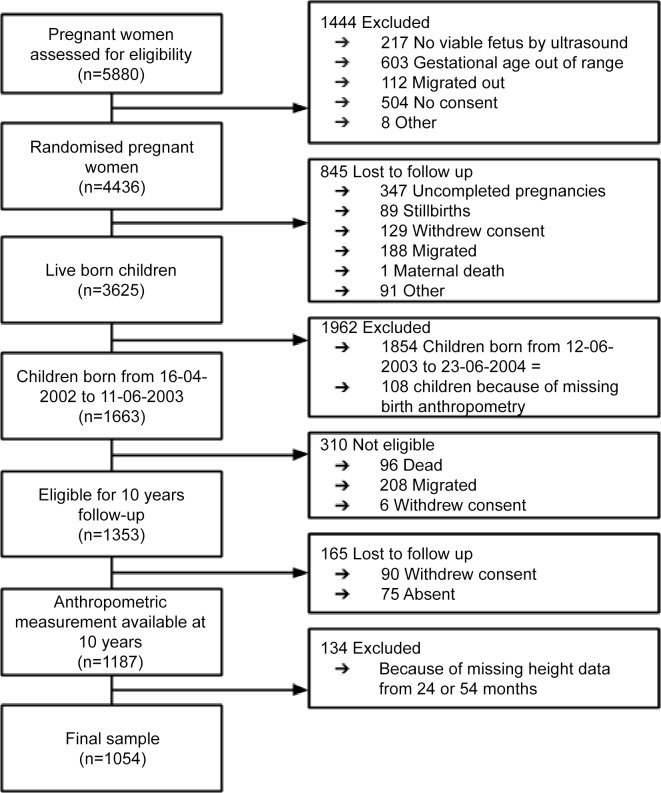
Flow Chart of children participating in the MINIMat trial from birth to 10 years of age.